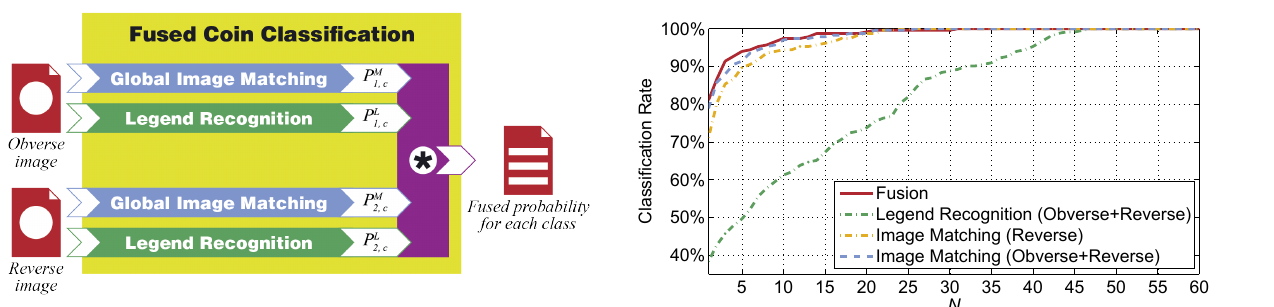
Figure 4: (a) Training of SVMs. (b) Legend Recognition Pipeline.